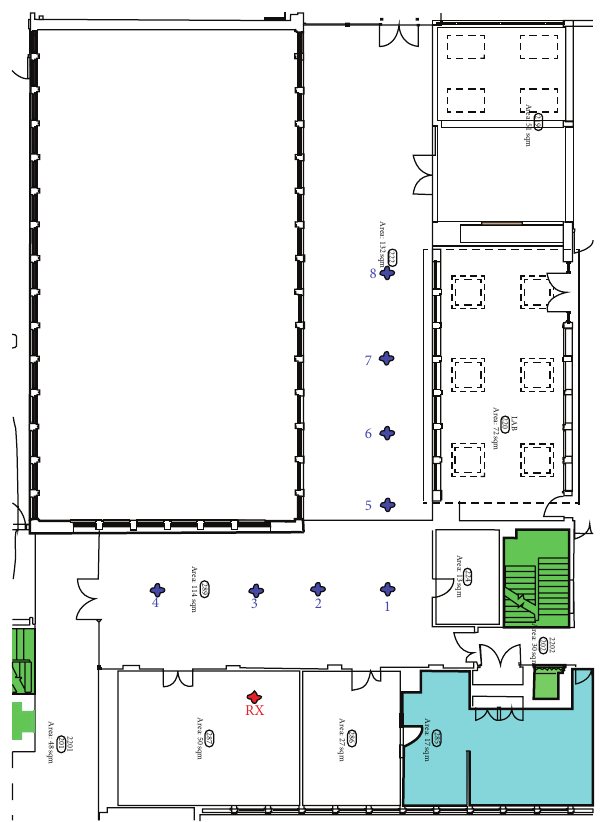
Figure 7: Building floor map of the uplink scenario.